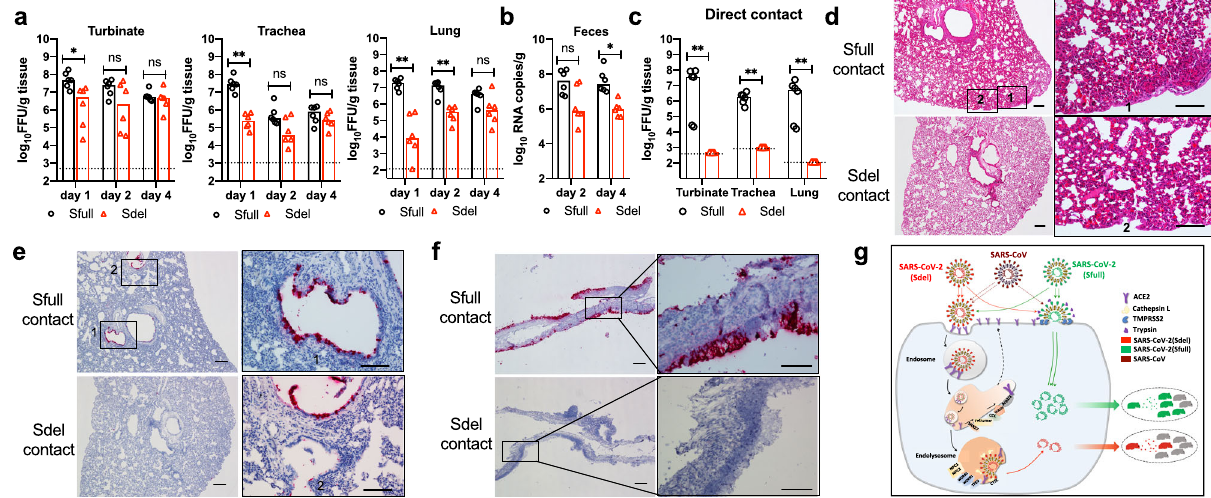
Fig. 5 The switch of virion entry pathways modulates the infection and transmission in hamsters. a Viral load in the tissues of nasal turbinate, trachea, and lung. Tissues were harvested at days 1, 2, and 4 post challenge of Sfull or Sdel virus (n = 6 per day). b Viral RNA in fecal samples. Fresh fecal samples were collected at days 2 and 4 post infection of Sfull or Sdel strain ( n = 6 per day) for qRT-PCR. c Transmission of Sfull or Sdel strain in hamsters by direct contact exposure. Naïve hamsters ( n = 6) were each co-housed with one inoculated donor at day 1 for 3 days. Hamsters were sacri fi ced and the indicated tissues were harvested for titration. The dashed lines represent the limit of detection by focus-forming assay. Median viral titers ( a – c ): two-tailed Mann – Whitney test; * P < 0.05; ** P < 0.01; n.s. not signi fi cant. d H&E staining of lung sections of contact hamsters. Representative images are shown from n =